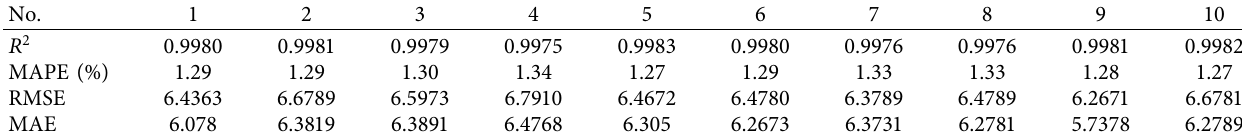
Table 5: Error results of the ten-fold cross-validation.